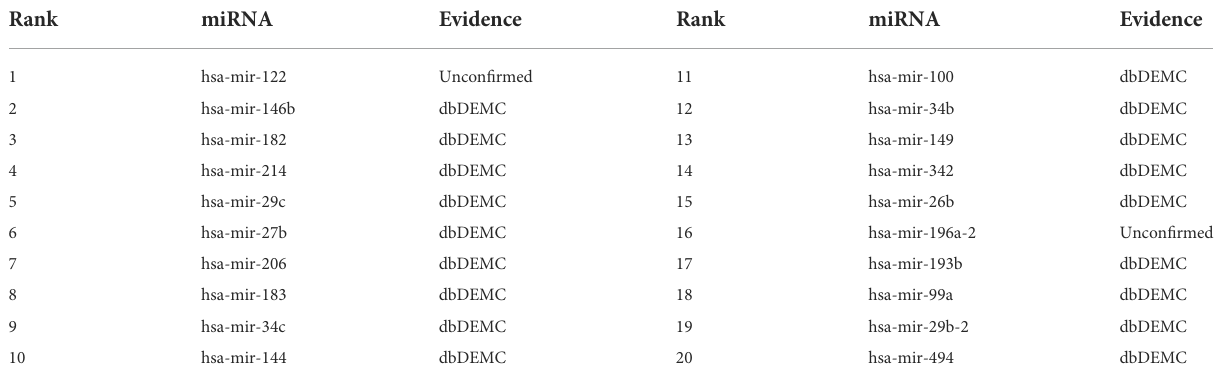
TABLE 4 Top 20 miRNA candidates related to colonic neoplasms.